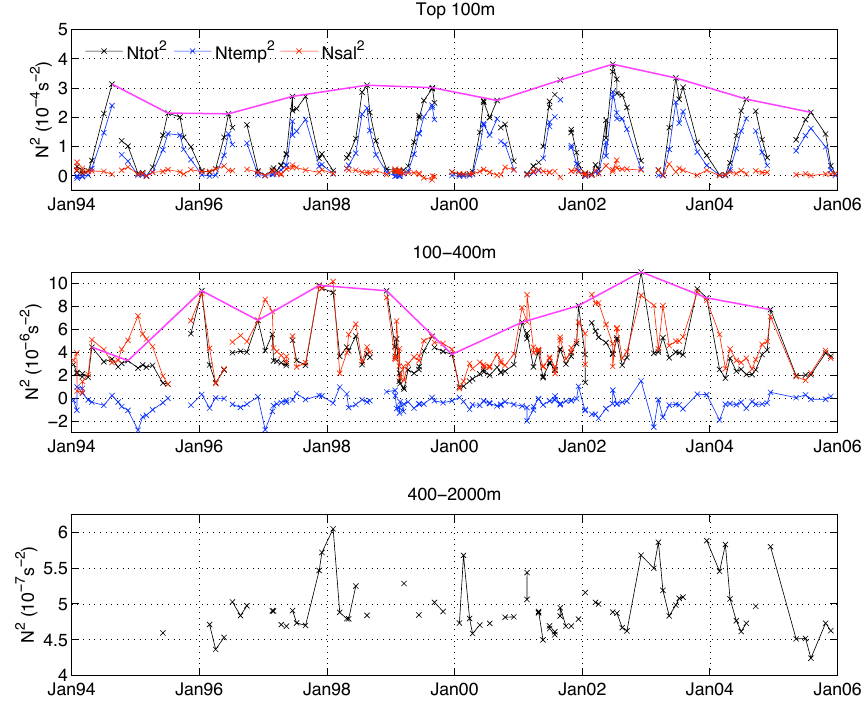
Fig. 7. Depth averaged vertical buoyancy gradients for the top, intermediate and bottom layers from the Dyfamed data set.